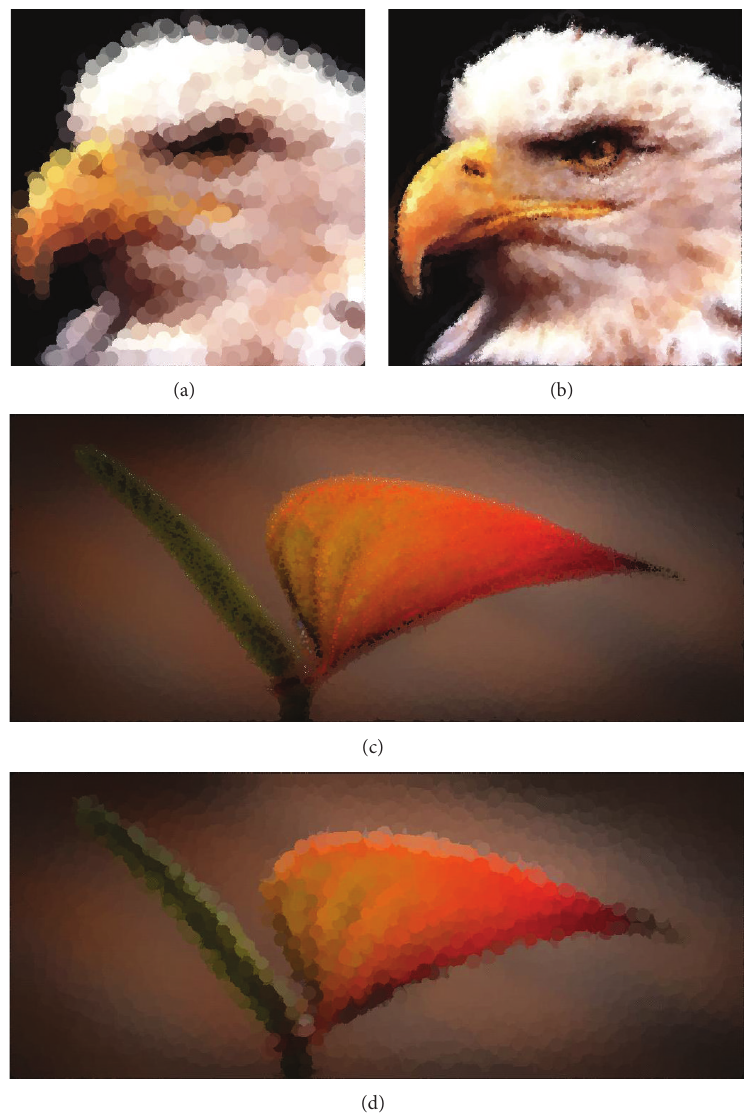
Figure 8: ((a), (c)) Pointillism without direction map and with edge map to decide the dot size; ((b), (d)) Pointillism without direction map and with equalized standard deviation map of the edge map to decide the dot size. All other settings are as same as those in Figures 2(d) and